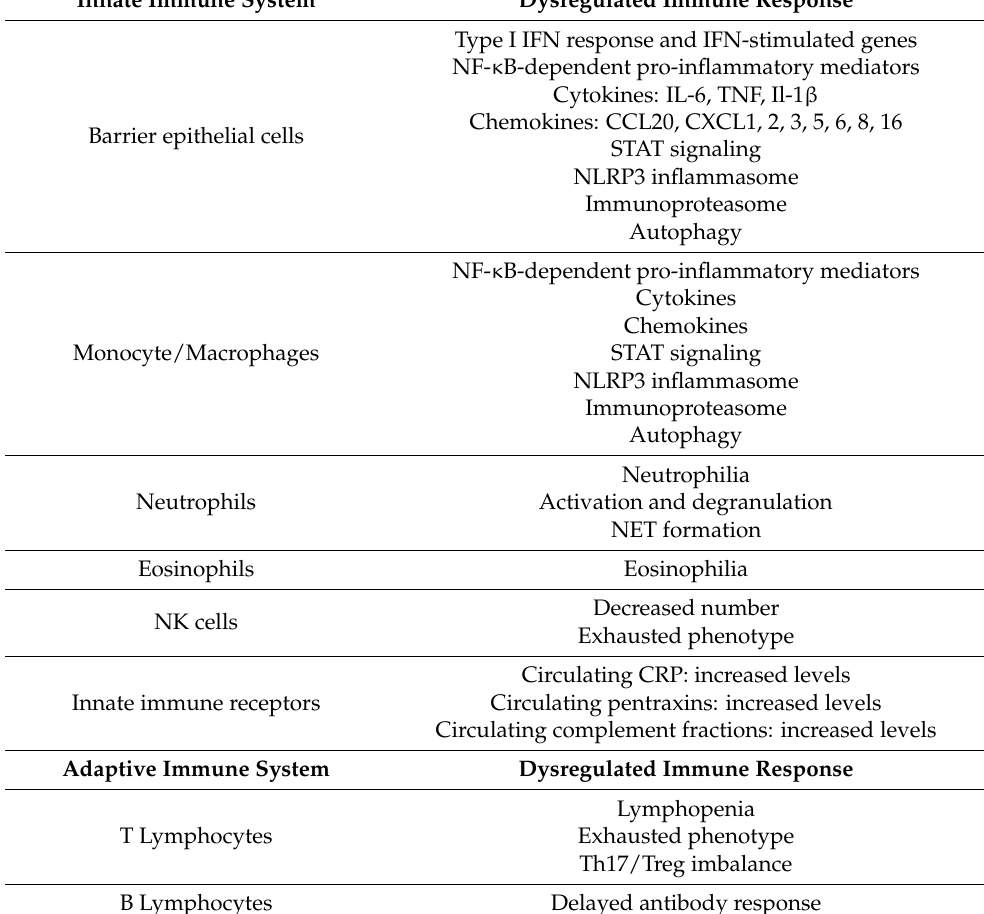
Table 1. Immunological biomarkers of severe COVID-19 as potential targets of